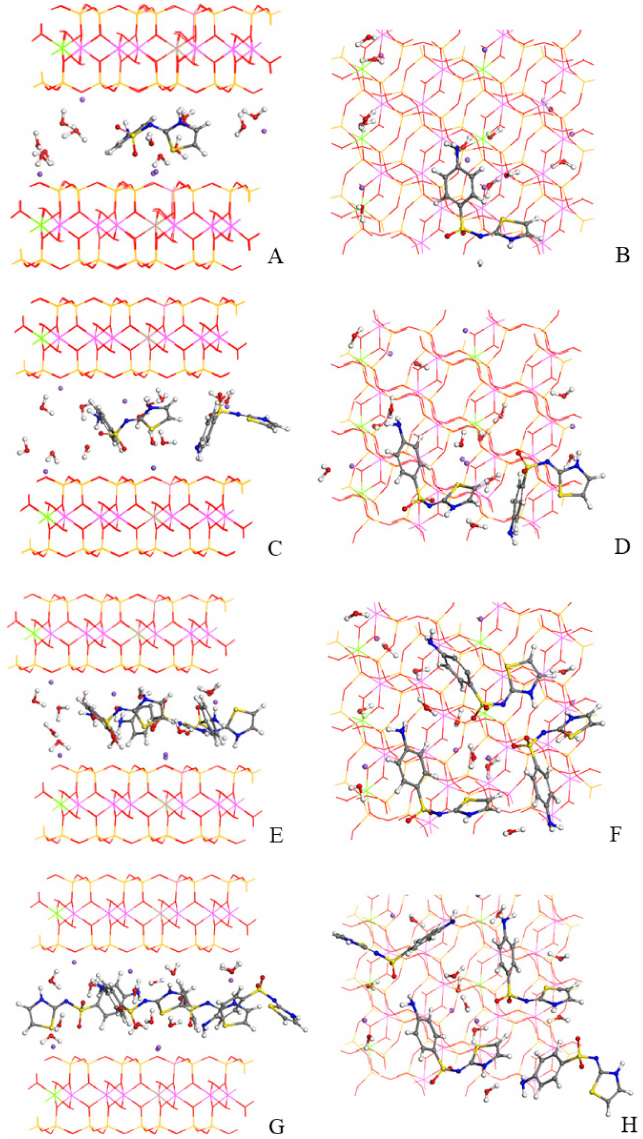
Figure 8. Optimized intercalation models of MMT with one ( A , B ), two ( C , D ), three ( E , F ), and four ( G , H ) STZ molecules per supercell, respectively. Views from (010) ( A , C , E , G ) and (001) ( B , D , F , H ) planes. Silicon atoms are represented in yellow, oxygen in red, aluminum in pink, magne- sium in green, hydrogen in white, and sodium atoms in